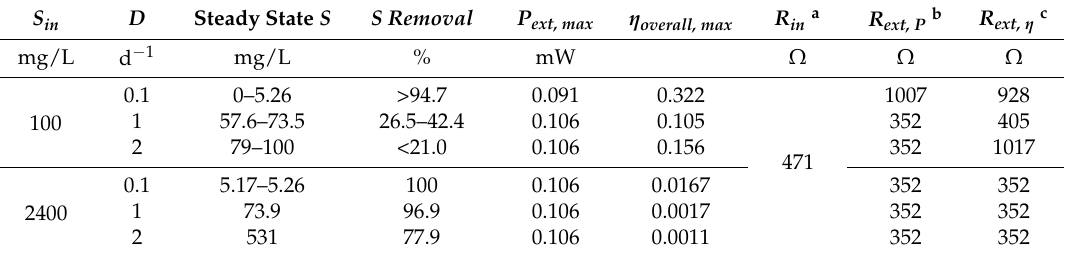
Simulated MFC performance: substrate removal, power generation and overall energy